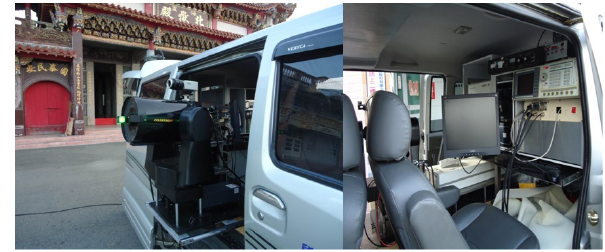
Figure 2. The mobile lidar system and vehicle